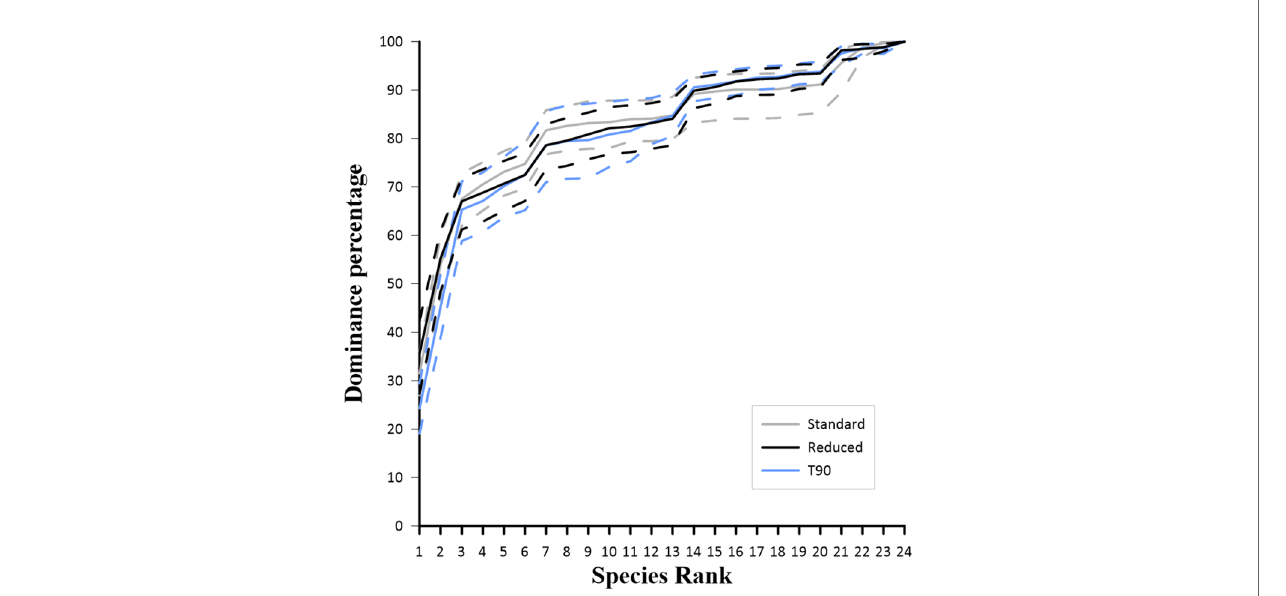
FIGURE 6 | Catch dominance cumulative curves for the three con fi gurations tested (Standard, Reduced, T90). The stippled curves represent the 95% CIs .